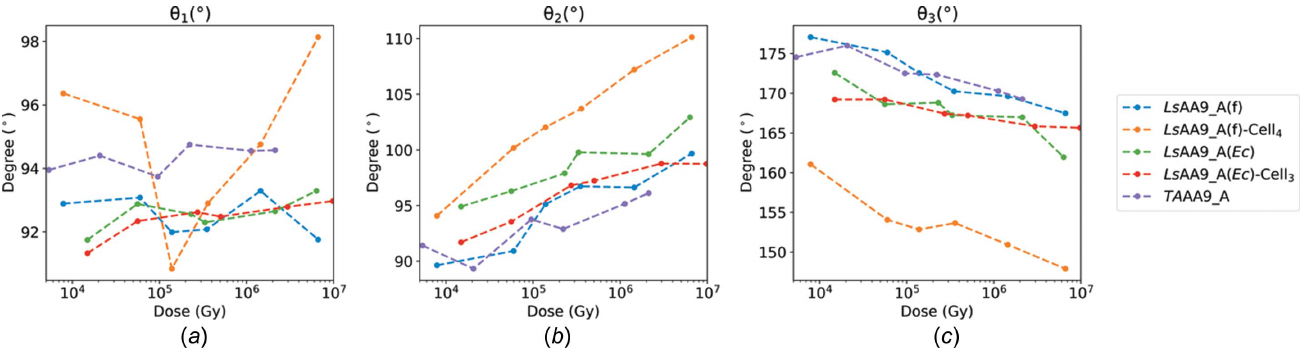
Figure 4 Measured active-site angles (cid:2) 1 , (cid:2) 2 and (cid:2) 3 as a function of the average diffraction weighted radiation dose. A consistent observation for all proteins in the photoreduction study is an increase in (cid:2) 2 and a decrease in (cid:2) 3 , while (cid:2) 1 is less consistent. All angles are listed in Table S7.